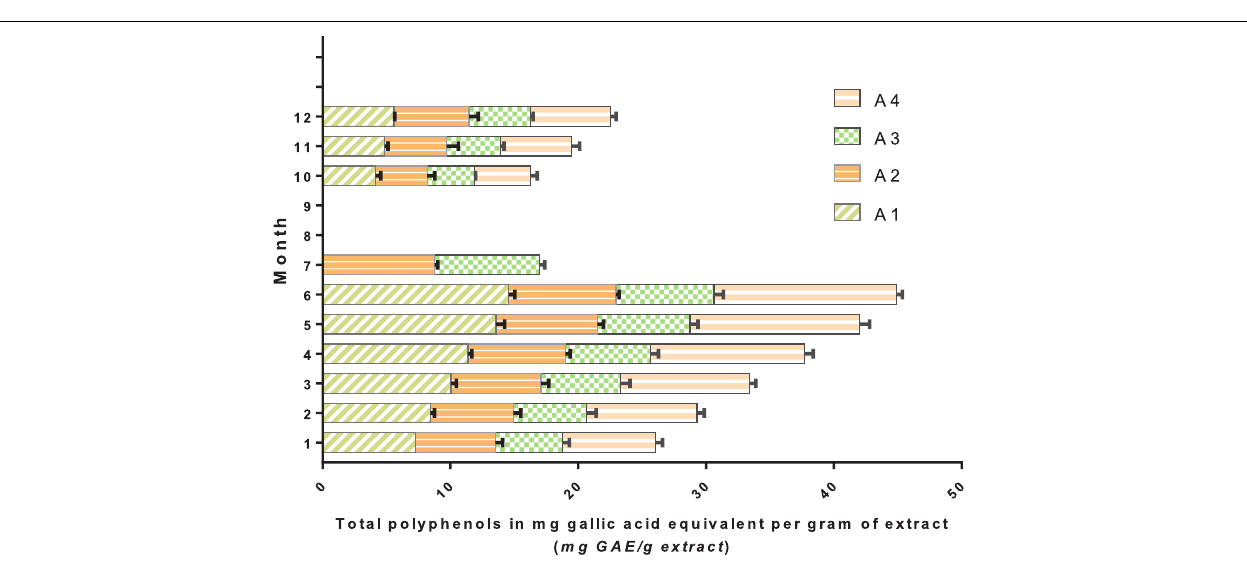
FIGURE 7 | Variability of total polyphenols in Withania frutescens (L.) Pauquy shown by month.